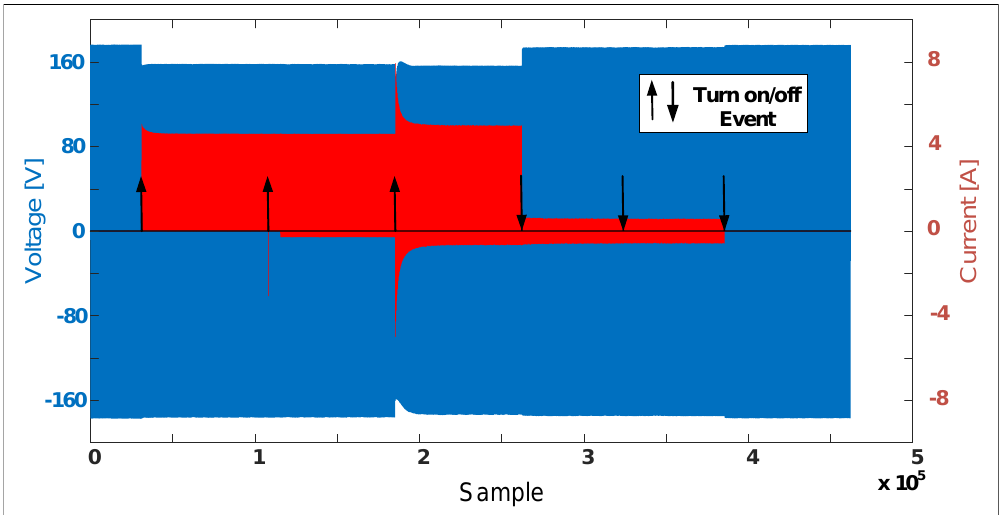
Figure 16. Jig acquisition of three loads: hairdryer at low power level, LED lamp, and drill—trigger angle of 225 degrees. AC mains voltage and